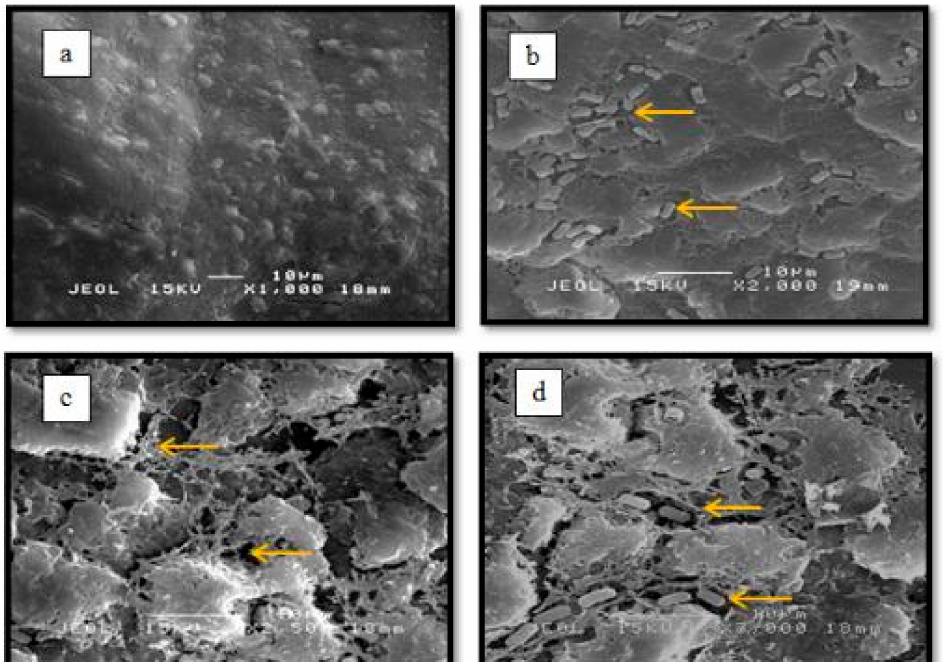
Figure 5. Attachment and interaction of C. gloeosporioides, T. asahii and papaya peel after three days of inoculation, viewed using scanning electron microscope. ( a ) papaya peel without any inoculation, ( b ) papaya peel inoculated with T. asahii (arrows show yeast cells), ( c ) papaya peel inoculated with C. gloeosporioides spores (arrows show fungal hyphae) and ( d ) papaya peel inoculated with C. gloeosporioides and T. asahii (arrows show yeast cells attached to fungal